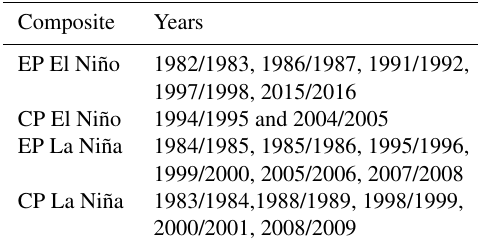
Table 2. Events composited for AGCM and observations.